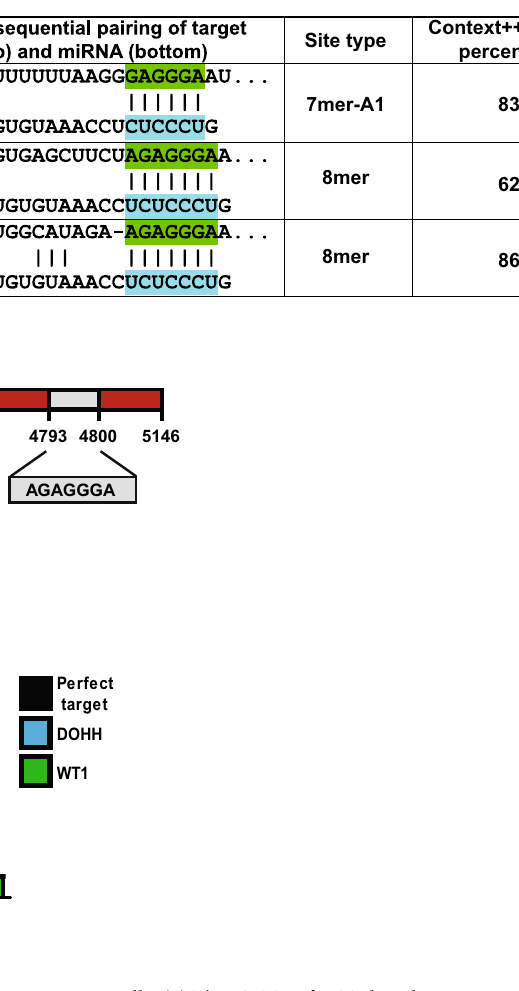
Figure 4. WT1 is a direct target of miR-642a-5p in PCa cells. ( a ) The 3 ′ UTR of WT1 has three putative miR- 642a-5p seed sites as predicted by TargetScan 7.2. ( b ) Schematic of the 3 ′ UTR of WT1 (not to scale). Depiction of the GeneCopoeia target clone, which contains only the first 1293 base pairs of the 3 ′ UTR, is with green shading. The grey shaded boxes indicate the miR-642a-5p seed sites. ( c ) Luciferase reporter gene analysis of the 3 ′ UTR of the putative miR-642a-5p target WT1 in 22Rv1 and LNCaP PCa cells transiently overexpressing miR- 642a-5p or miR-NC (20 nM). DOHH and miR-642a-5p perfect targets are positive controls. Error bars = SD; n = 3; ** p <